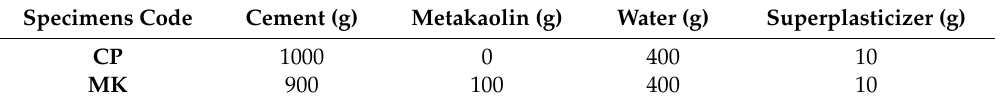
Table 3. Mix proportions of the cement paste. CP: Cement paste.